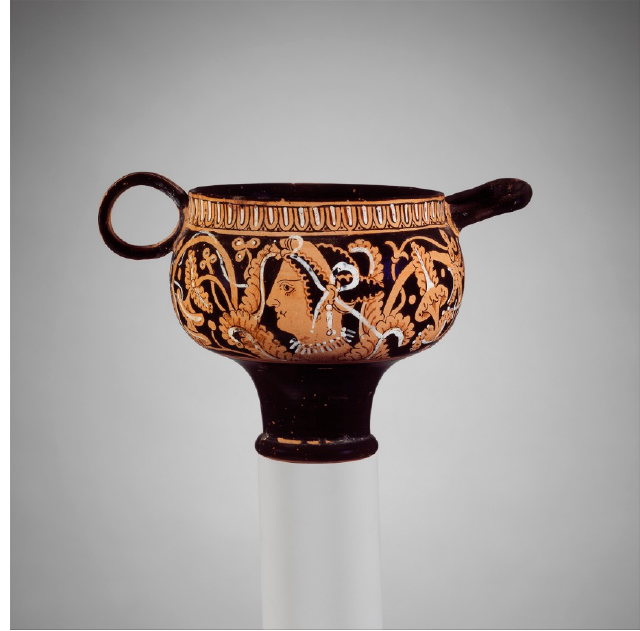
Figure 6. New York, Metropolitan Museum of Art 07.286.33 Etruscan skyphos, Tondo Group, ca. 325–300 B.C. Female head in profile to left in floral setting. Image © The Metropolitan Museum of Art.